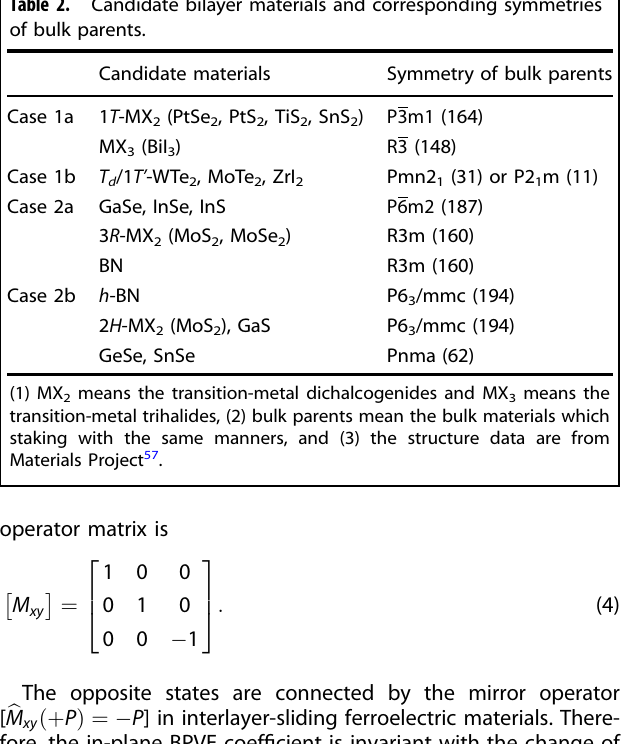
(1) The crystal structures here are abstract bilayers, and the orange quadrilateral indicates the abstract unit cell of monolayer; (2) S + and S − represent the bilayer with opposite sliding vectors.